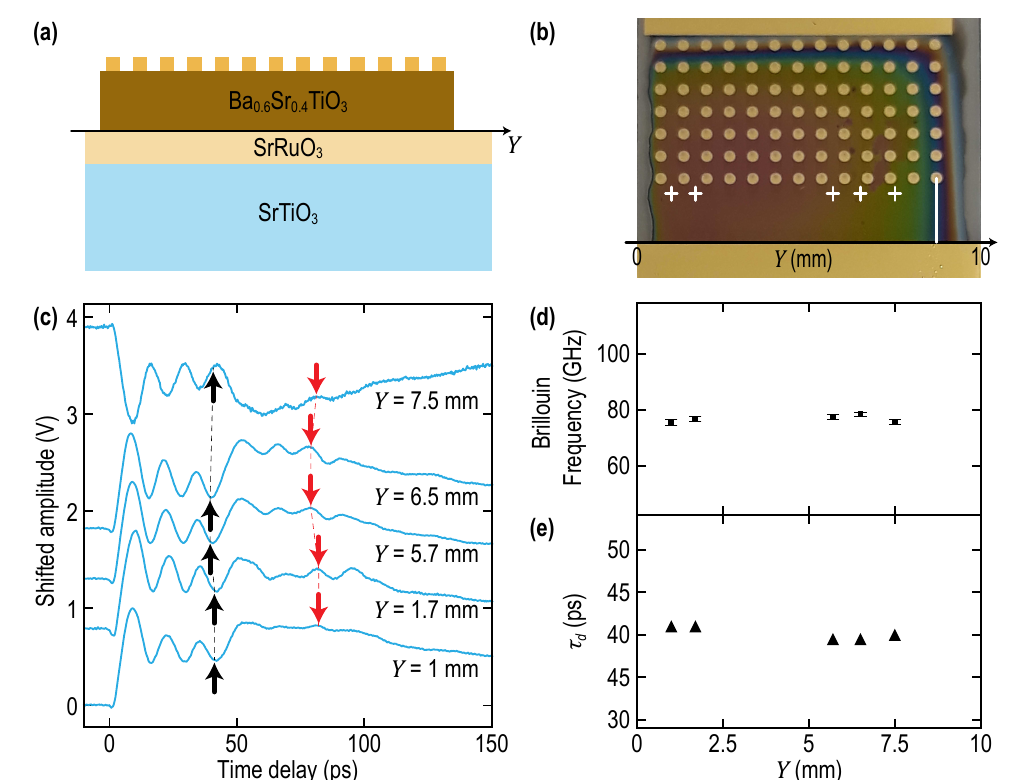
Figure 5. ( a ) The side view of the sample with BST0.4 thin film and ( b ) its optical image from the top of the sample, where the experimental points are marked by crosses. The variations in colors reflect the changes in the film thickness of less than 10–15% in the positions from 1 mm to 7.5 mm. ( c ) Transient reflectivity signals in the different lateral experimental positions. The Brillouin oscillations in the BST0.4 film are clearly visible. The arrivals of the CAP on the free surface of the film and its return to the SRO OAT are marked tentatively by black and red arrows (linked by dashed lines of the corresponding colors), respectively. ( d , e ) The dependences of the evaluated BF in BST0.4 and the estimated characteristic times τ d ≈ d / v BST 0.4 of CAP propagation across the film, respectively, on the coordinate along the sample